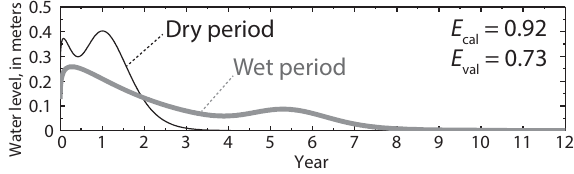
Figure 8. Example W1: impulse-response functions (IRFs) for well LA88C using double-gamma IRFs for both periods, i.e., wet and dry.